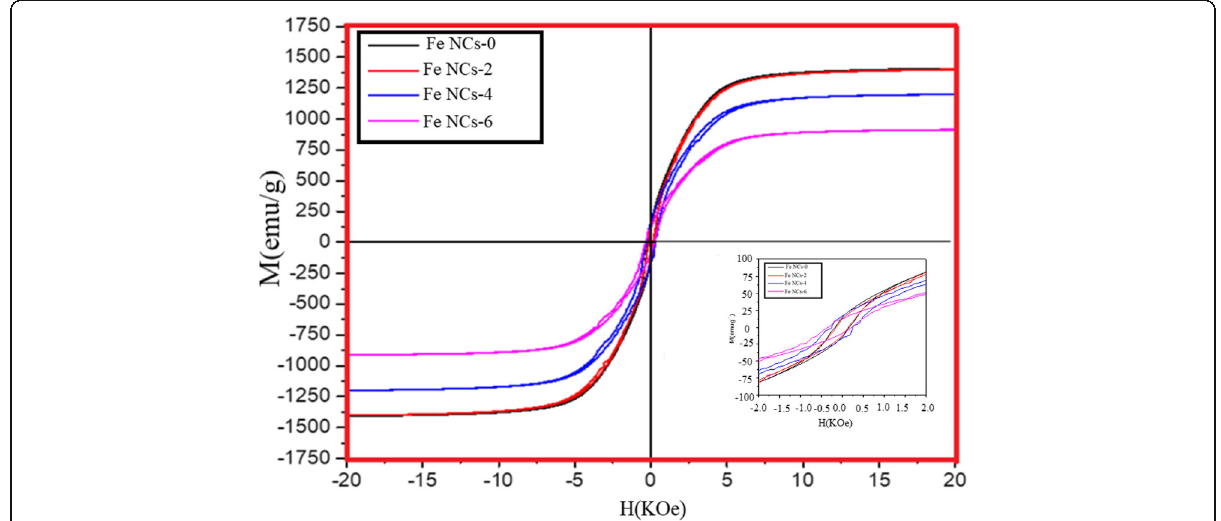
Fig. 11 Magnetic hysteresis measured at room temperature, inset shows the enlarged curve between – 2.0 and 2.0